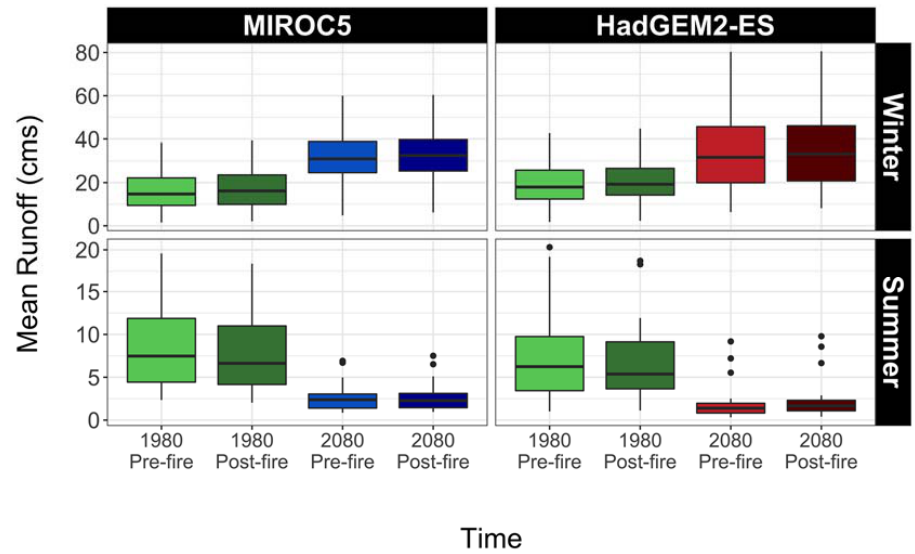
Figure 6. Seasonal flows for MIROC5 in RCP 4.5 and HadGEM2-ES in RCP 8.5 before and after forest cover reduction in comparison to historic conditions.